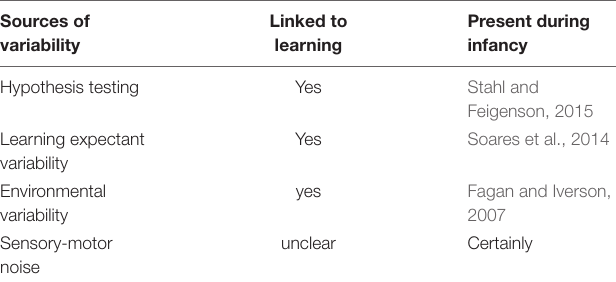
TABLE 1 | Potential sources of variable behavior in early motor